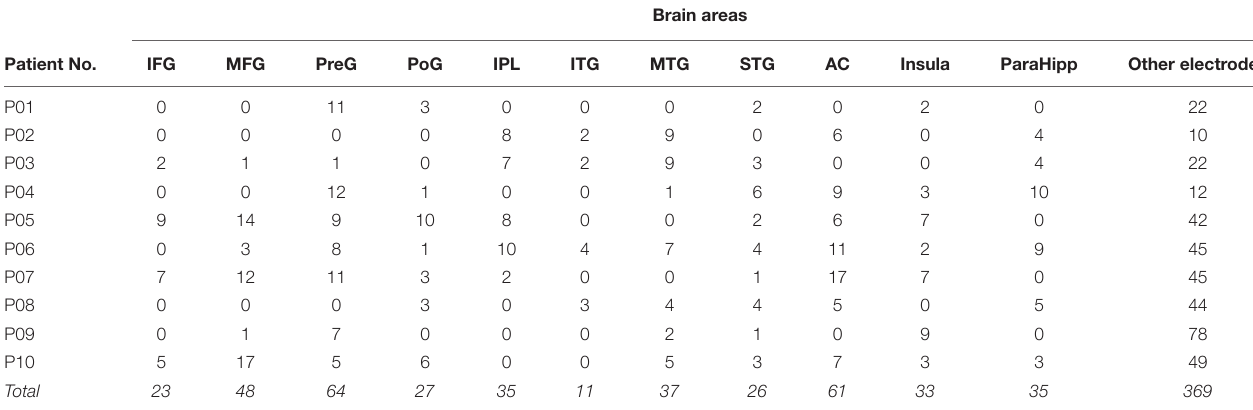
TABLE 2 | Electrodes distribution of individual participants.